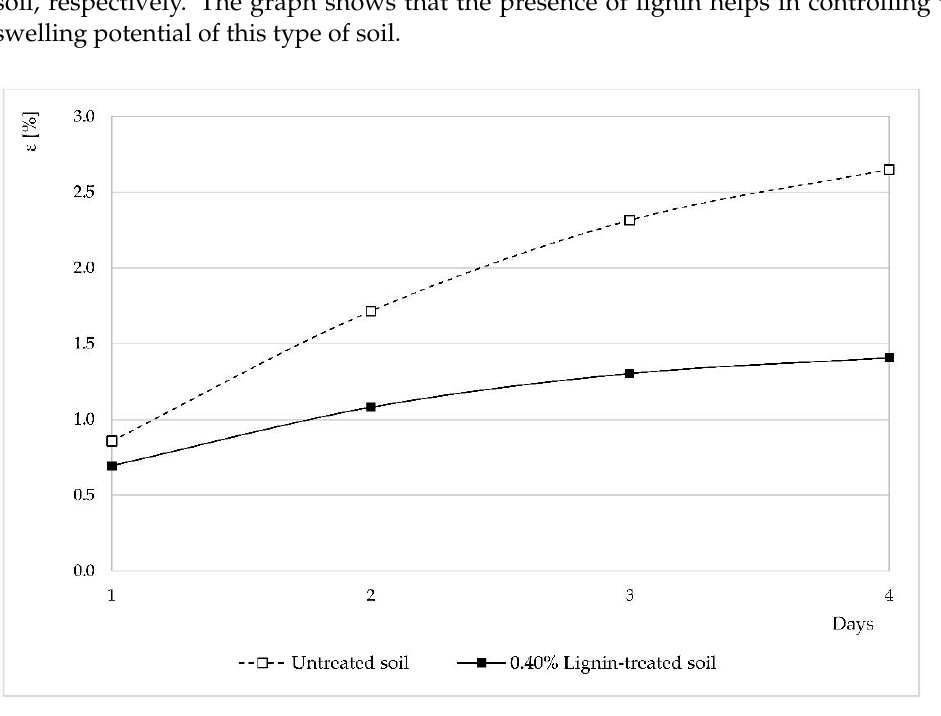
Figure 7. Time–swelling curve for the untreated soil and the 0.40% lignin-treated soil.